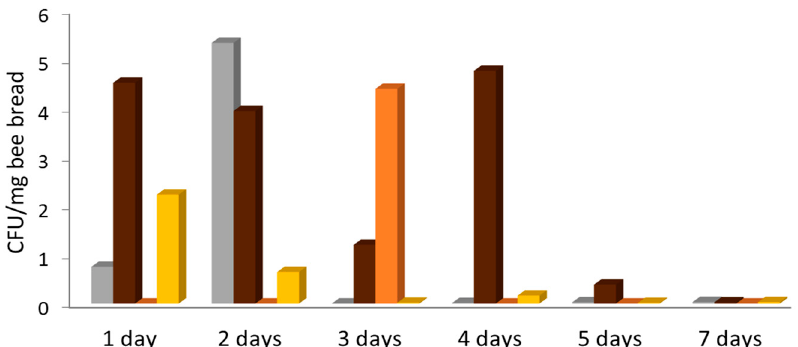
Figure 4. Number of yeast colonies per mg of fresh bee bread averaged over four samples at each time point. The exceptional occurrence of more than 40 CFU/mg of S. cerevisiae in a single seven-day sample was not included for clarity. Grey: Metschnikowia , brown: Starmerella , orange: Zygosaccharomyces , yellow: other genera.